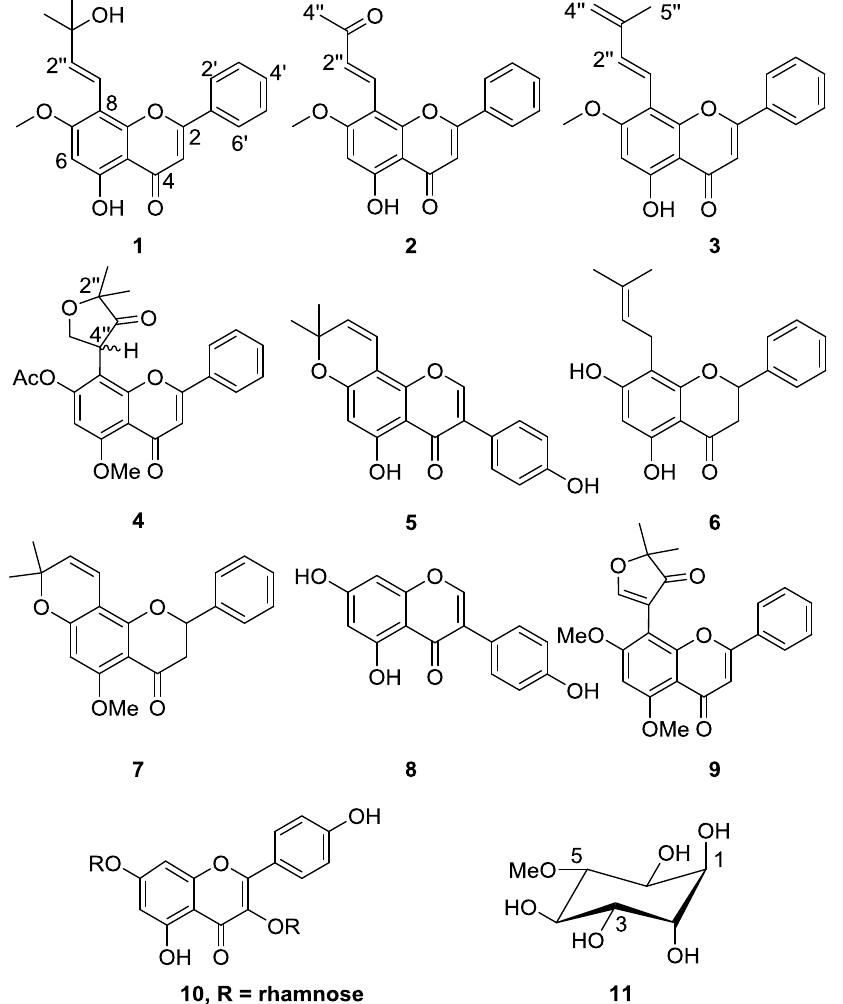
Figure 1. Structures of compounds isolated from T. purpurea subsp. leptostachya.